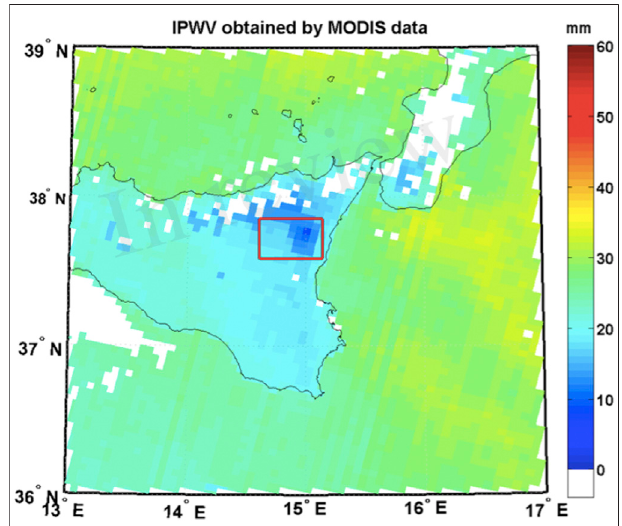
FIGURE 3 | IPWV map acquired by the MODIS on August 22, 2015 at 01:10UTC.Theredboxindicatestheareade fi nedtoperformthecomparison betweenMODISandGPSIPWV.Whitepixelscorrespond